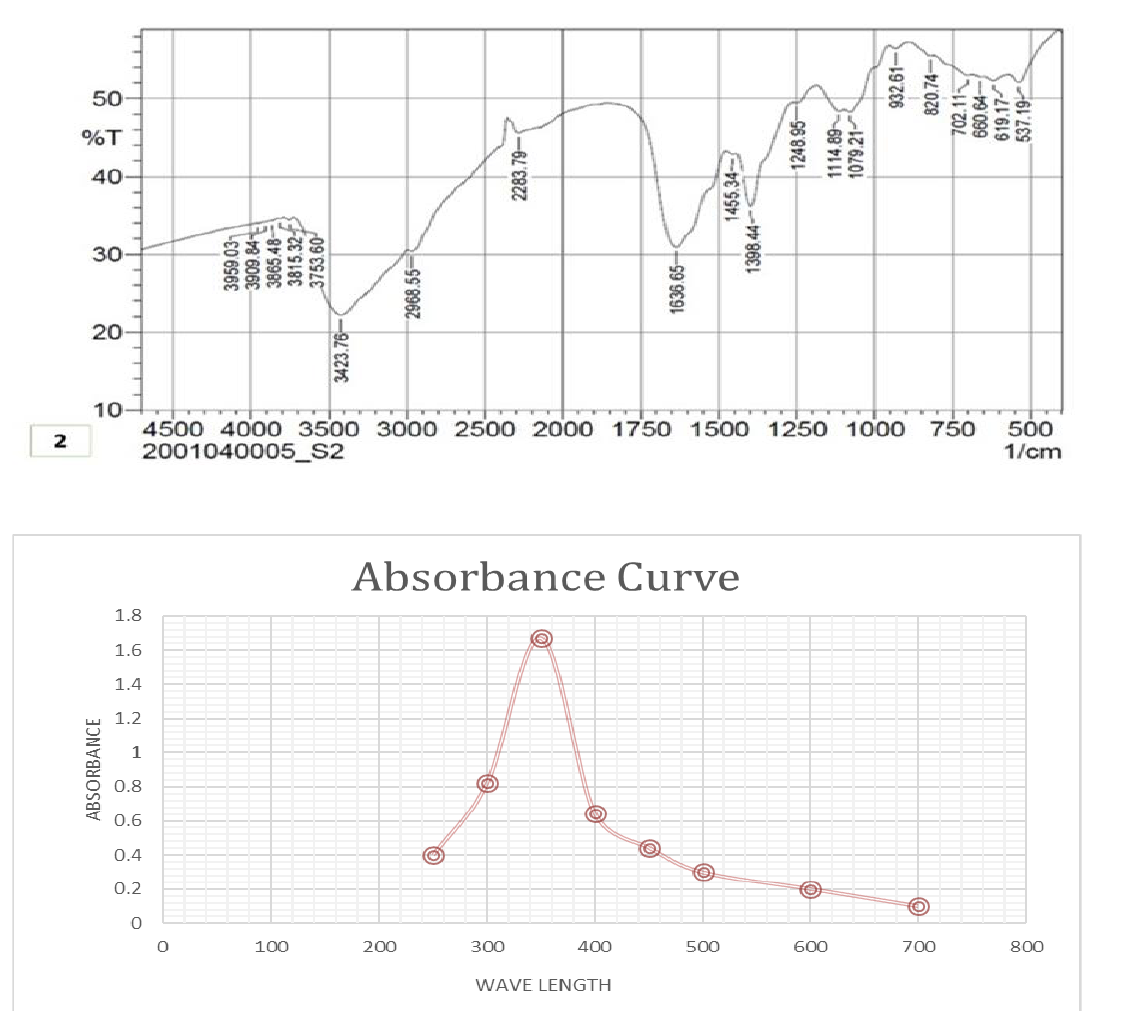
Figure 4. XRD of silver nanoparticles formed by Acinetobacter baumannii